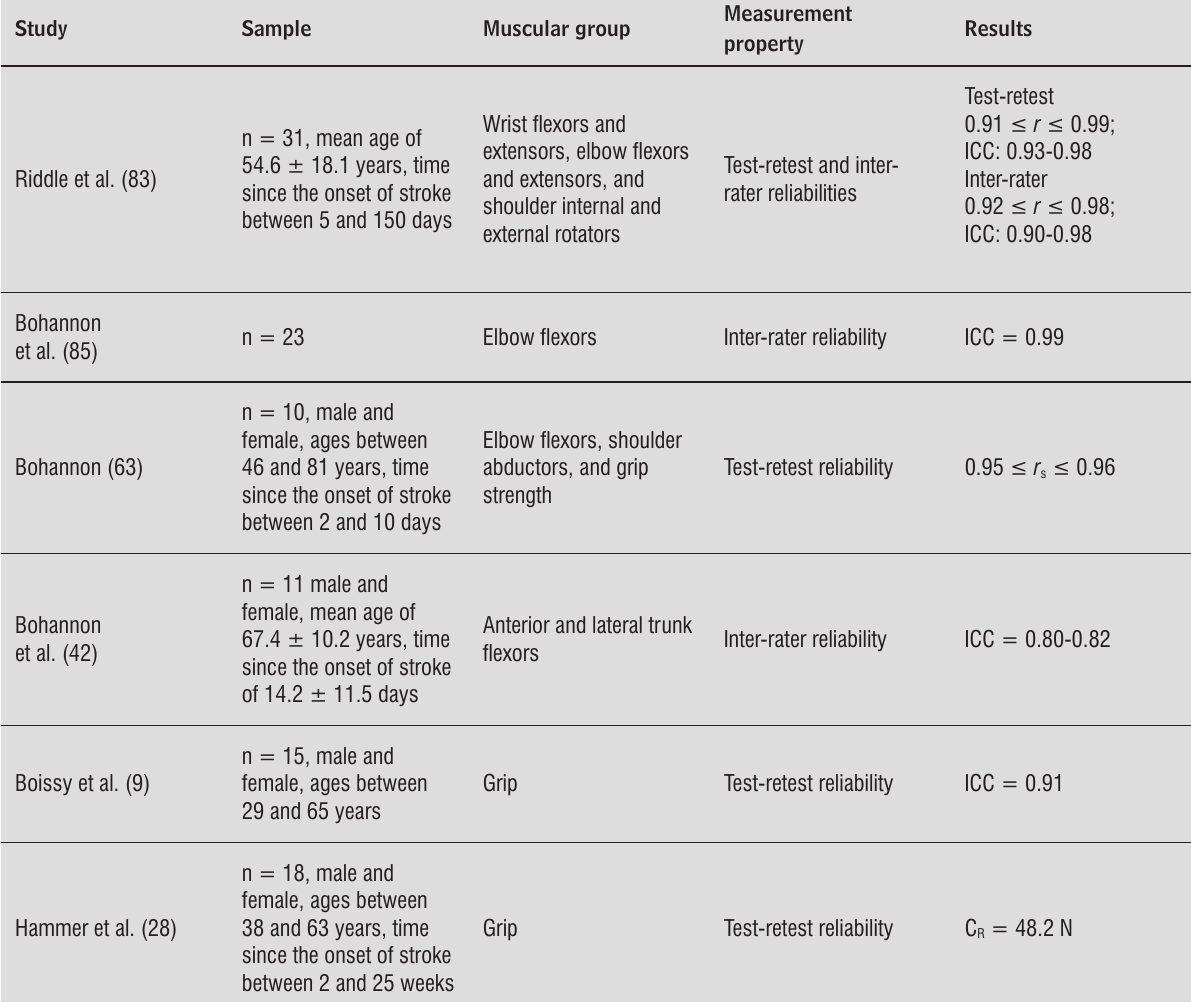
Table 5 - Results of the nine studies which assessed the measurement properties of the portable dynamometers